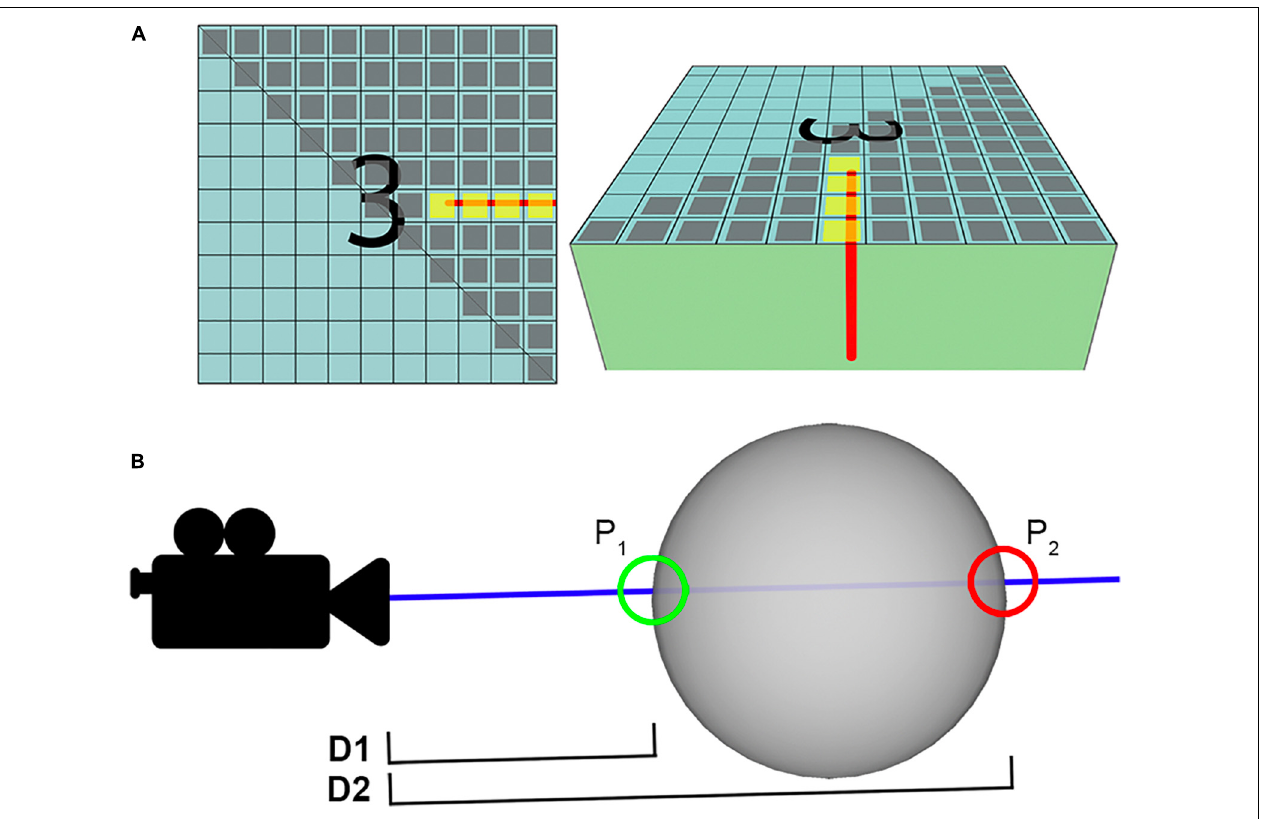
FIGURE 5 | NeMO-Net 3D painting algorithm. (A) The process of converting screen space drawings into texture space. Each gray pixel tests collision against the user generated stroke to determine if the pixel is being painted. (B) Pixel occlusion. D1 is the distance to the nearest visible pixel, P 1 . D2 is the distance to the pixel in question, P 2 . D2 (cid:54)= D1 → P 1 occludes P 2